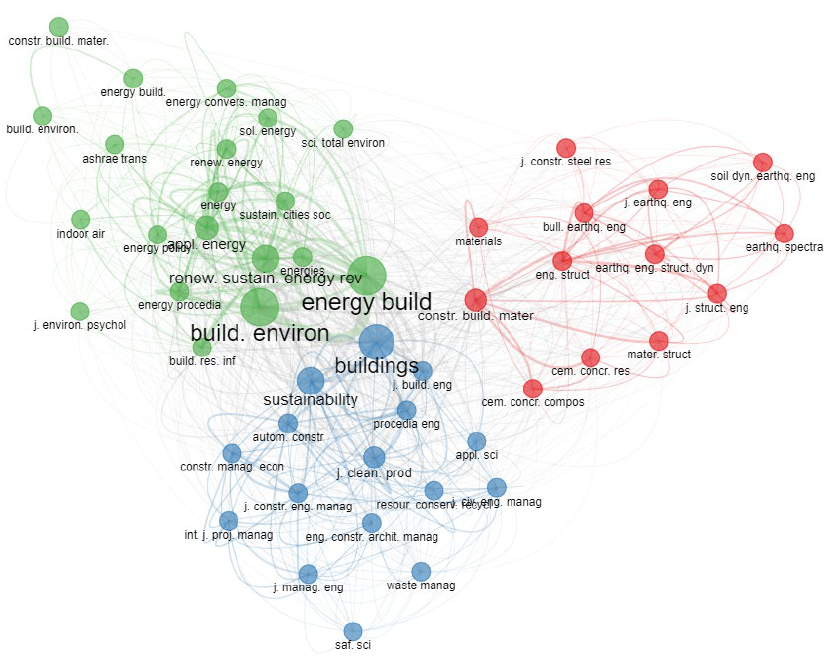
Figure 10. Co-citation network of